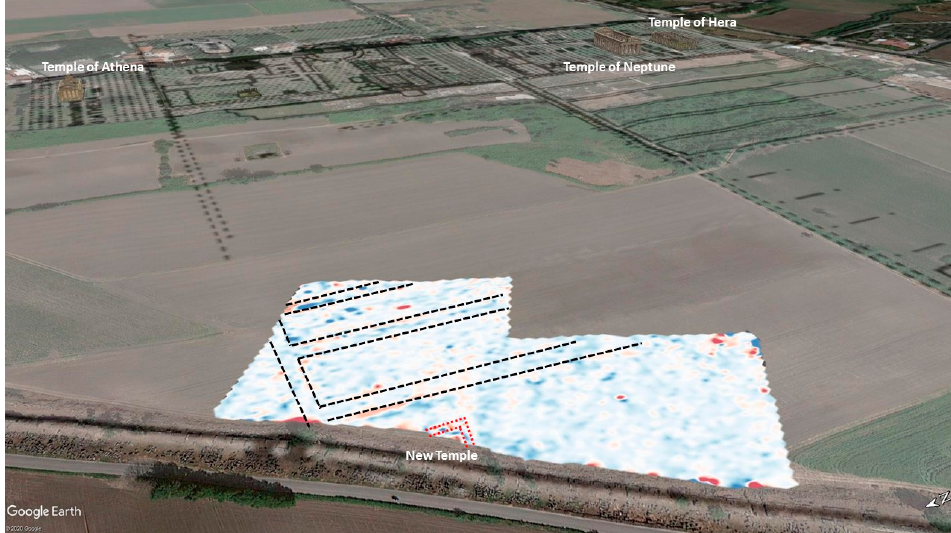
Figure 5. Geomagnetic map overlapped on the satellite image of the area. The resulting image is also merged with the ancient map of the city [19]. The black dashed lines identify the main streets oriented according to the NS ( stenopoi ) and EW ( plateia ) axes. The red dashed lines define the discovered temple.